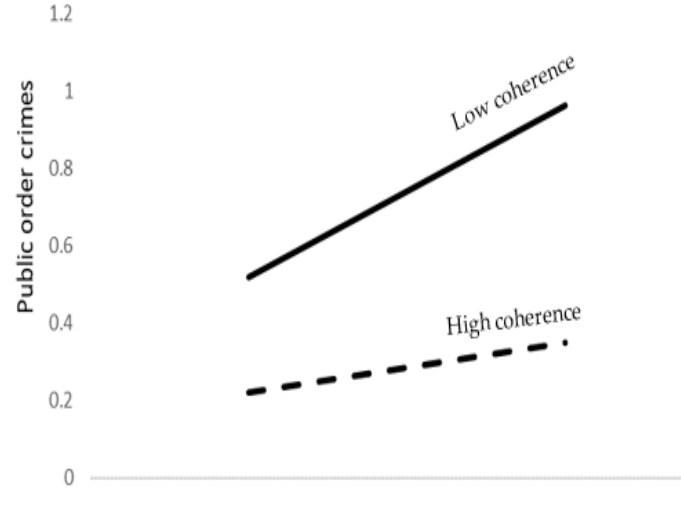
Figure 5. The association between ADHD symptoms and public order crimes as moderated by coherence. The SEM model accounted for 18% of the drug’s antisocial behavior variance. As shown in Table 8, older age, male gender, lower religiosity levels, lower emotional symp- toms, higher ADHD symptoms, and lower coherence were significant predictors of drug use. In addition, ADHD symptoms by coherence interaction was found to be significant. Beta B As shown at the bottom of Table 8 and Figure 6, ADHD symptoms predicted drug use when coherence was low but not when high. Table 8. ADHD symptoms as a predictor of drug use moderated by coherence.